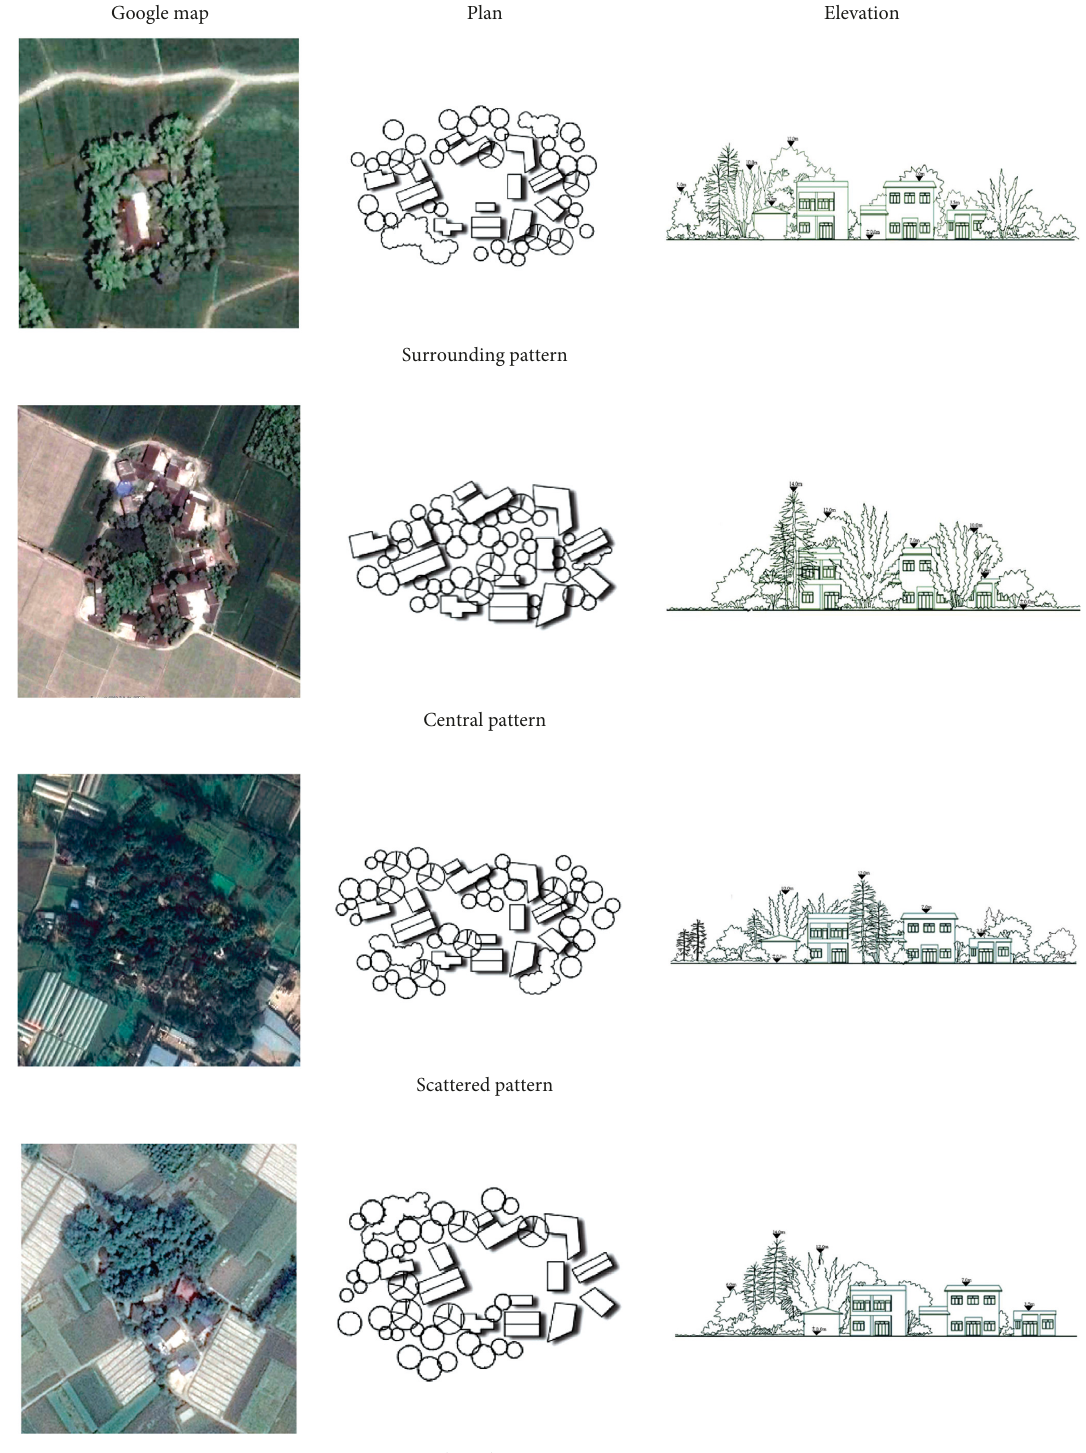
Figure 3: Tree distribution patterns of Linpan (drawing by